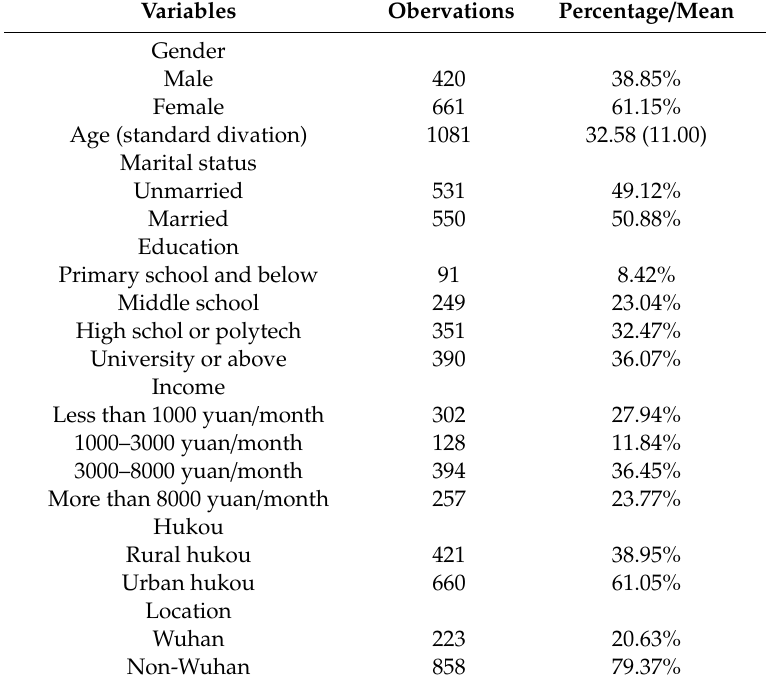
Table 2. Descriptive statistics of sampling